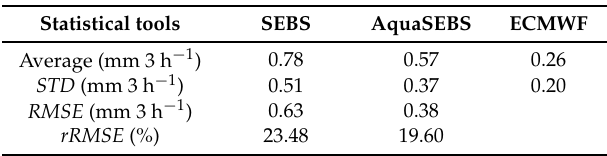
Table 8. Comparison of evaporation rates calculated by different models over the Great Salt Lake in the period of (January 2010 to September 2012).